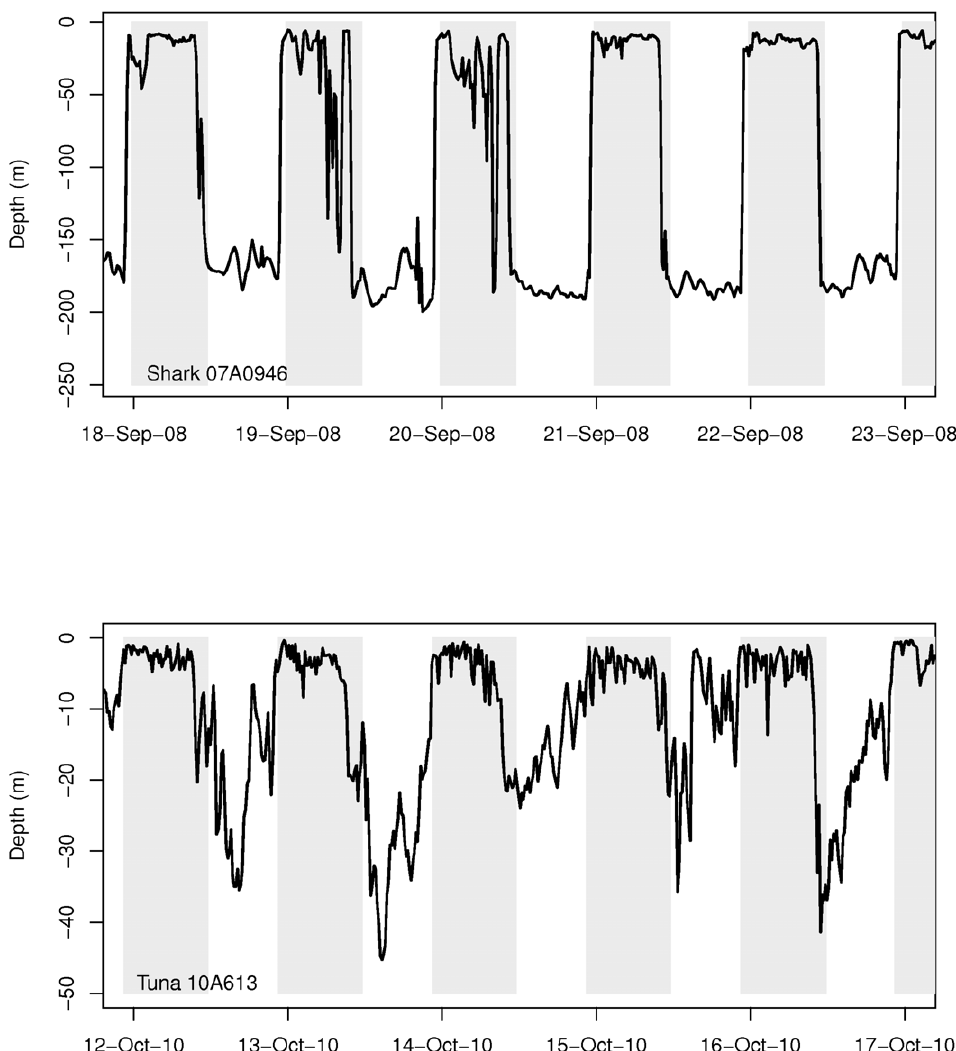
Figure 5. Actual vertical migration profiles of known predators. Upper panel (a): a porbeagle shark vertical profile ( # 07A0946) and lower panel (b): a bluefin tuna vertical profile ( # 10A613). The gray parts represent night period.